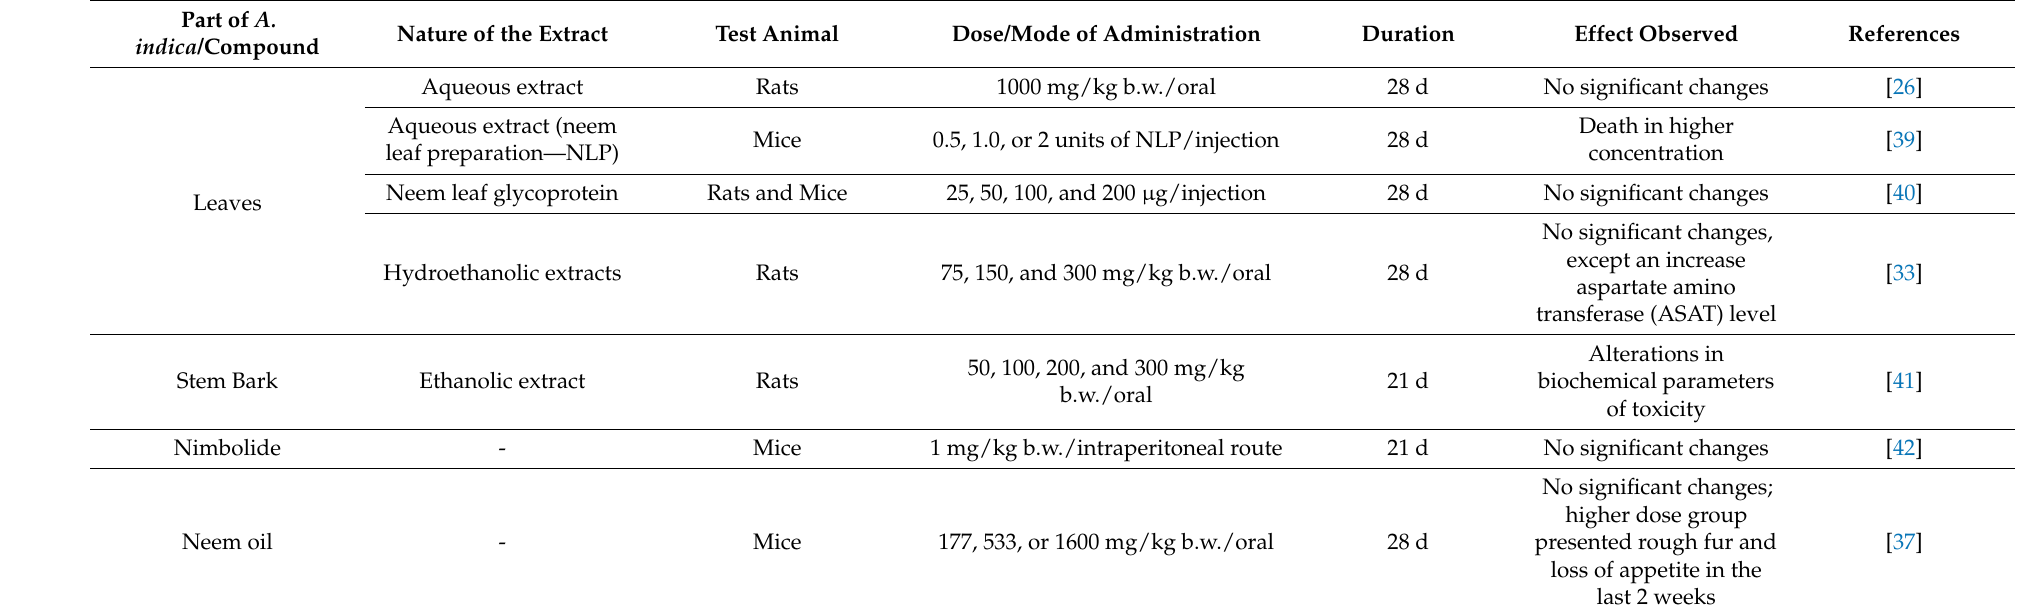
Table 3. Subacute toxicity of neem in different